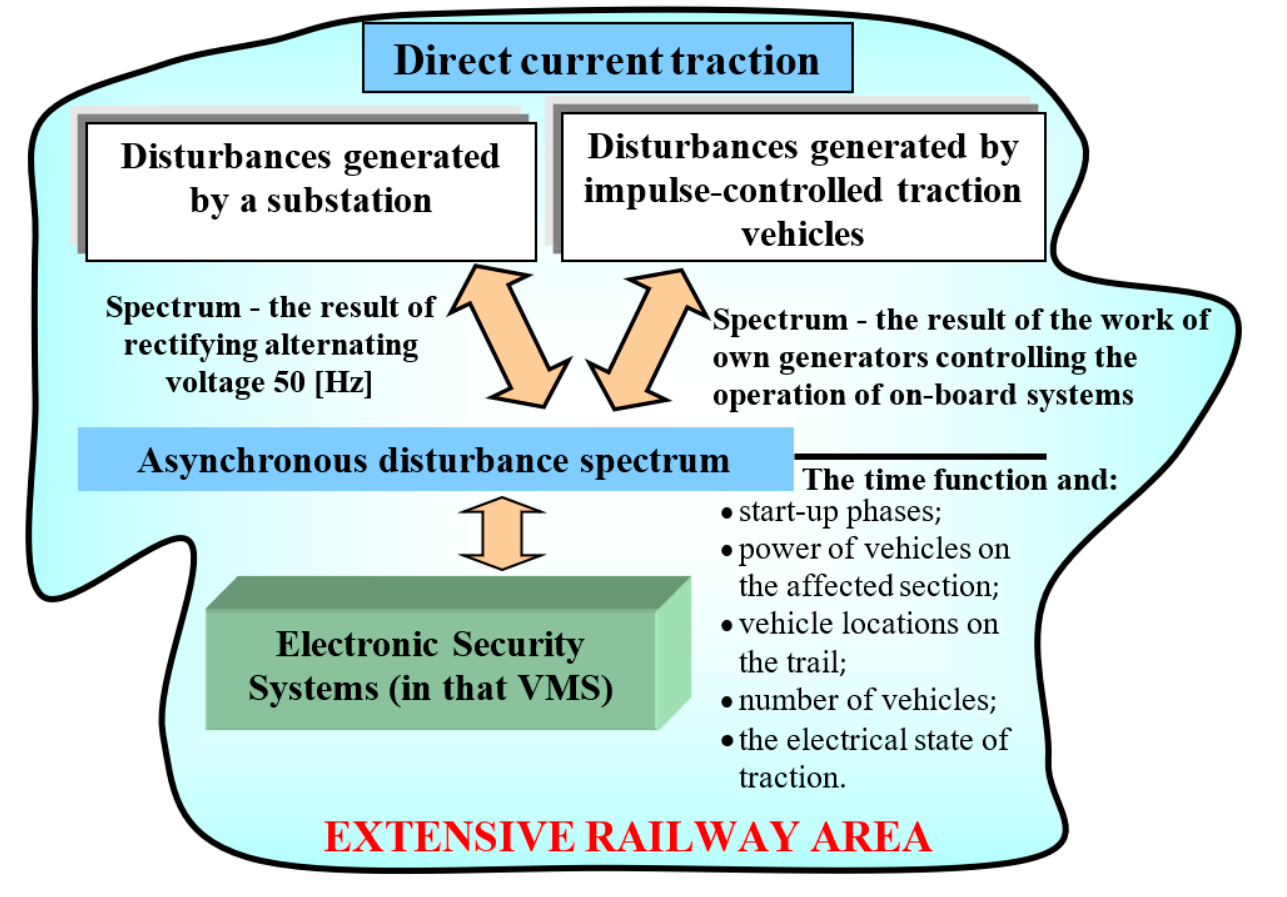
Figure 2. Electromagnetic interference generated by a power substation and traction vehicles over a vast railway area and its impact on VMS.